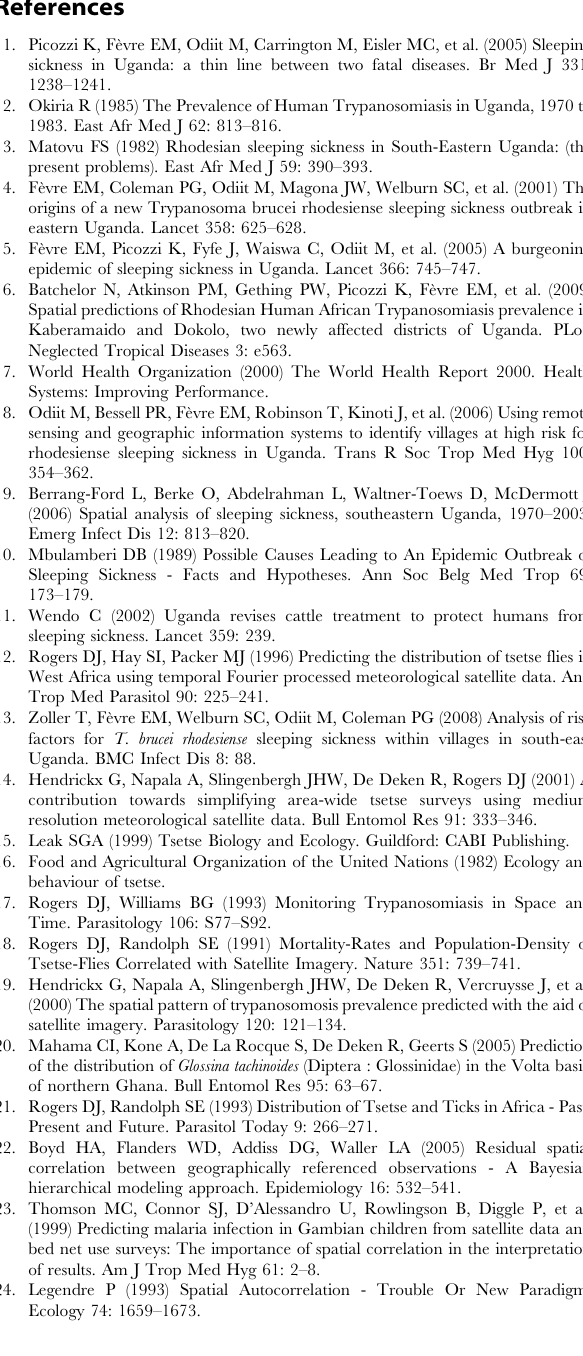
Figure S1 Posterior distributions for model parameters. Figure S2 Traceplots of MCMC output for each parameter. Figure S3 Autocorrelation plots of MCMC output for each